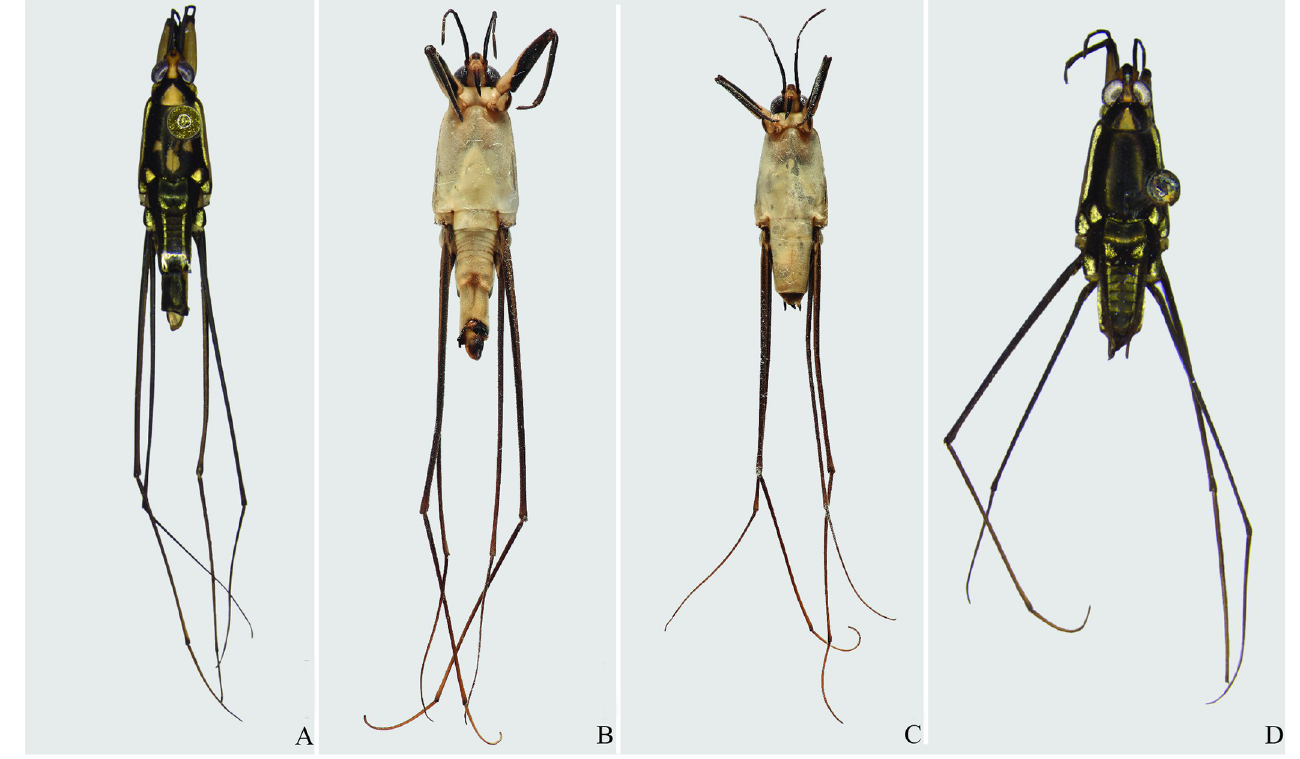
Fig 13. Potamobates anchicaya . (A) Male, dorsal view; (B) male, ventral view; (C) female, dorsal view; (D) female, ventral view.